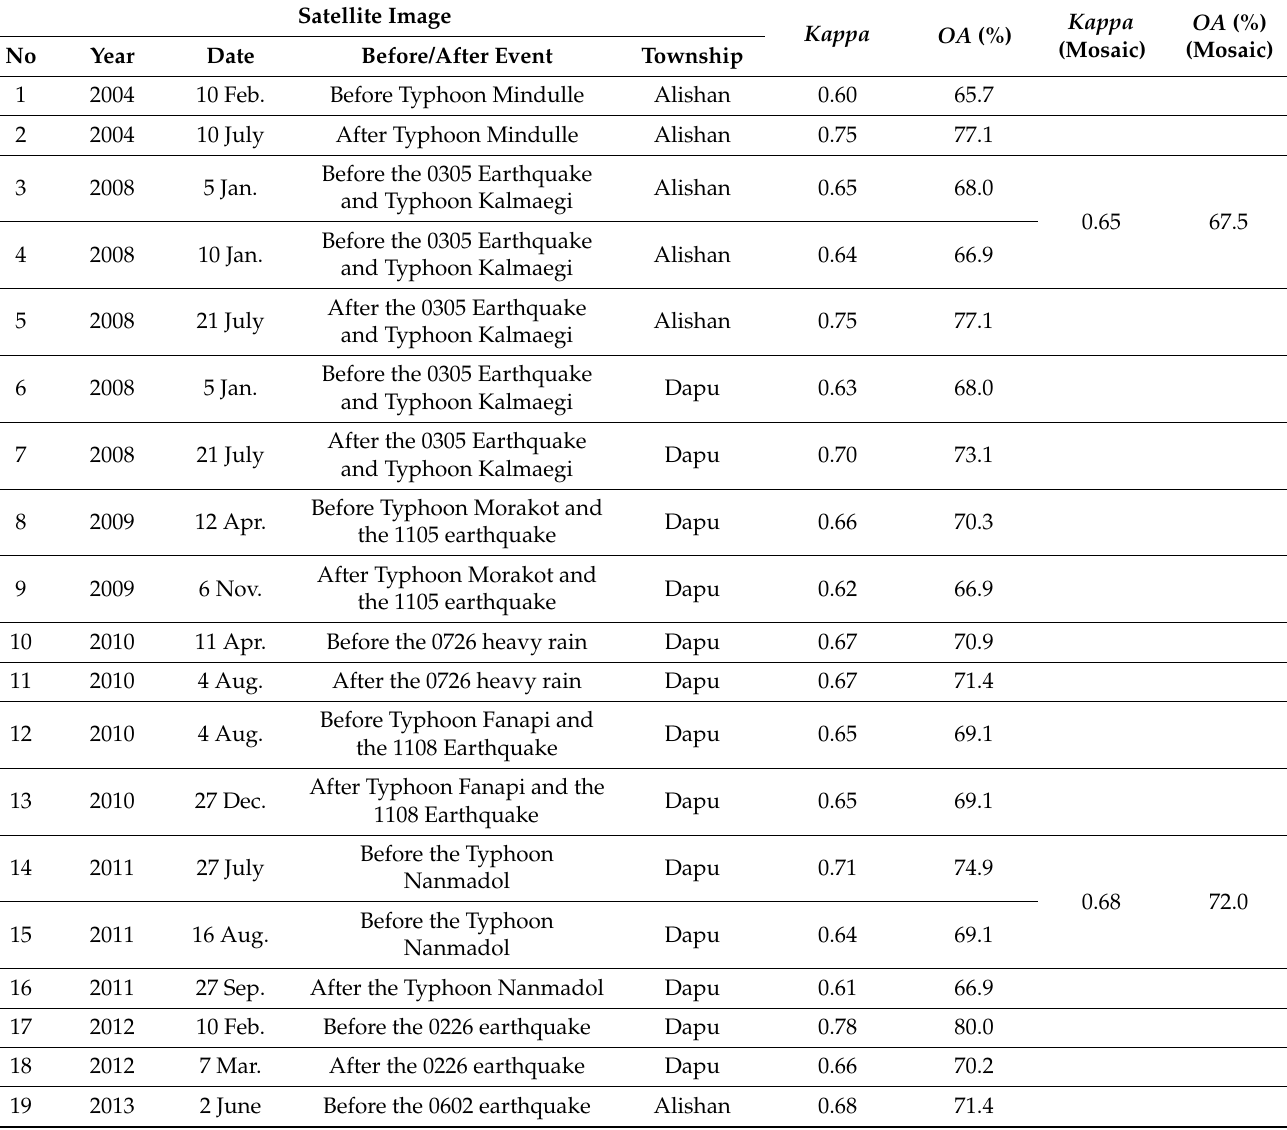
Table 1. Coefficient of agreement and overall accuracy of satellite image interpretation